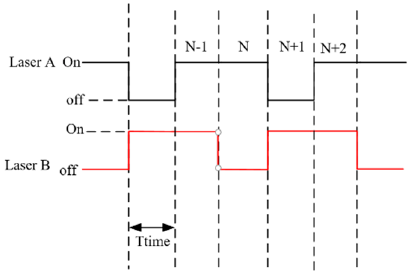
Figure 3. Cross − line laser work period.